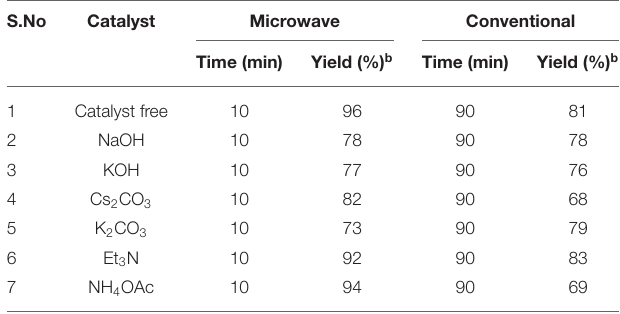
TABLE 1 | Optimized effect of solvent under catalyst-free for the 1,2,4-triazol-1,4-dihydropyridine ( 4a ) formation a . S.No